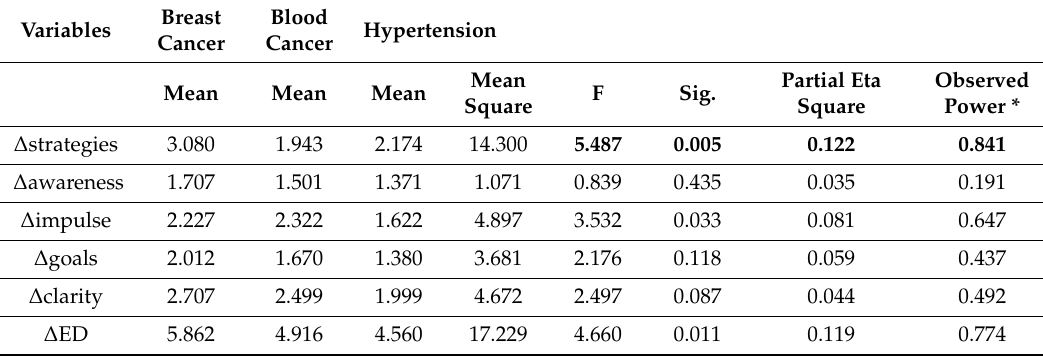
Table 8. Di ff erences between groups (one-way MANOVA); tests of between-subjects e ff ects. Breast Variables Cancer